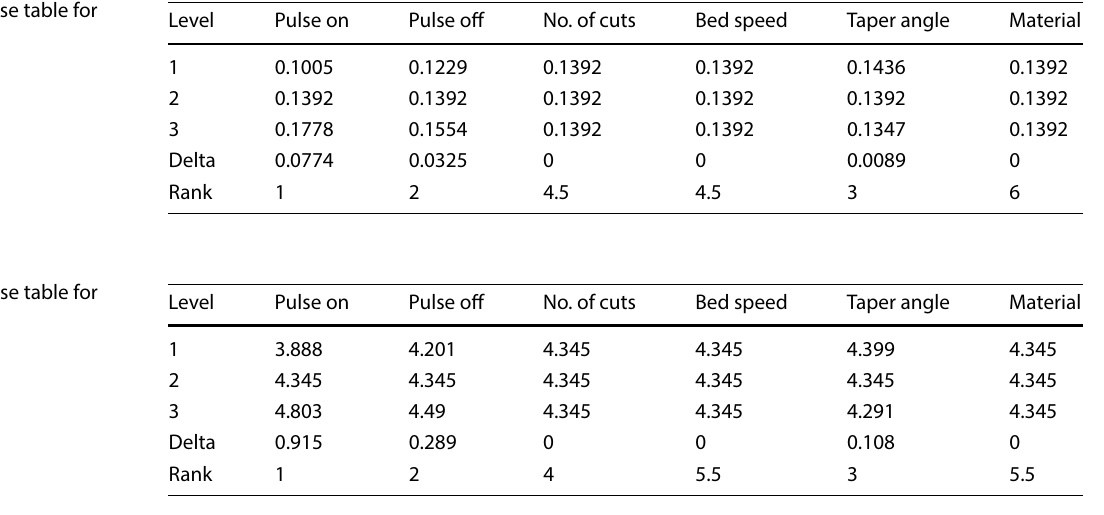
Table 13 Response table for means ( MRR )